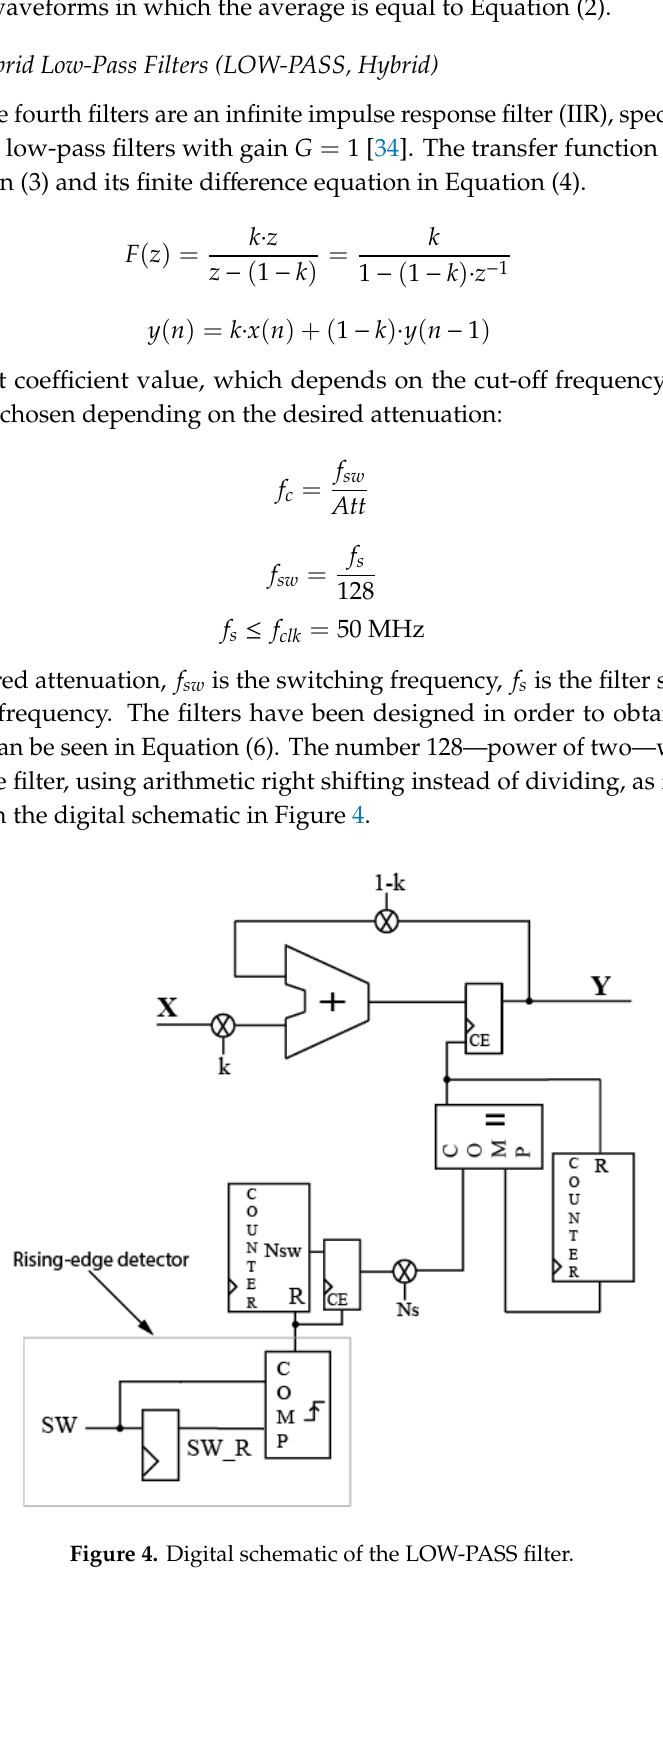
Figure 5. Comparison of the low pass and hybrid filter. A trade-off situation between delay and accuracy should be reached. A lower attenuating filter, which is faster, can be used and its output can be driven to an additional MAX-MIN filter. Figure 5 also shows the output of the 20 dB filter combined with MAX-MIN in two cases. The original MAX-